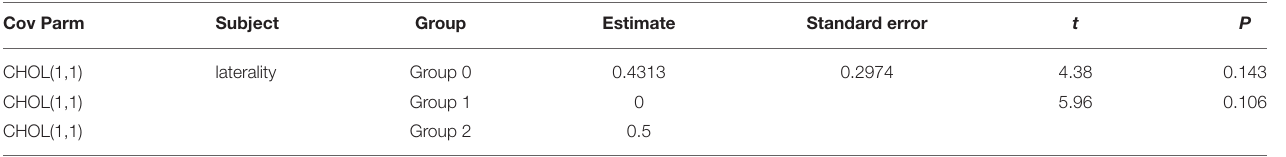
TABLE 5 | The results of random effects estimation in laterality for the null